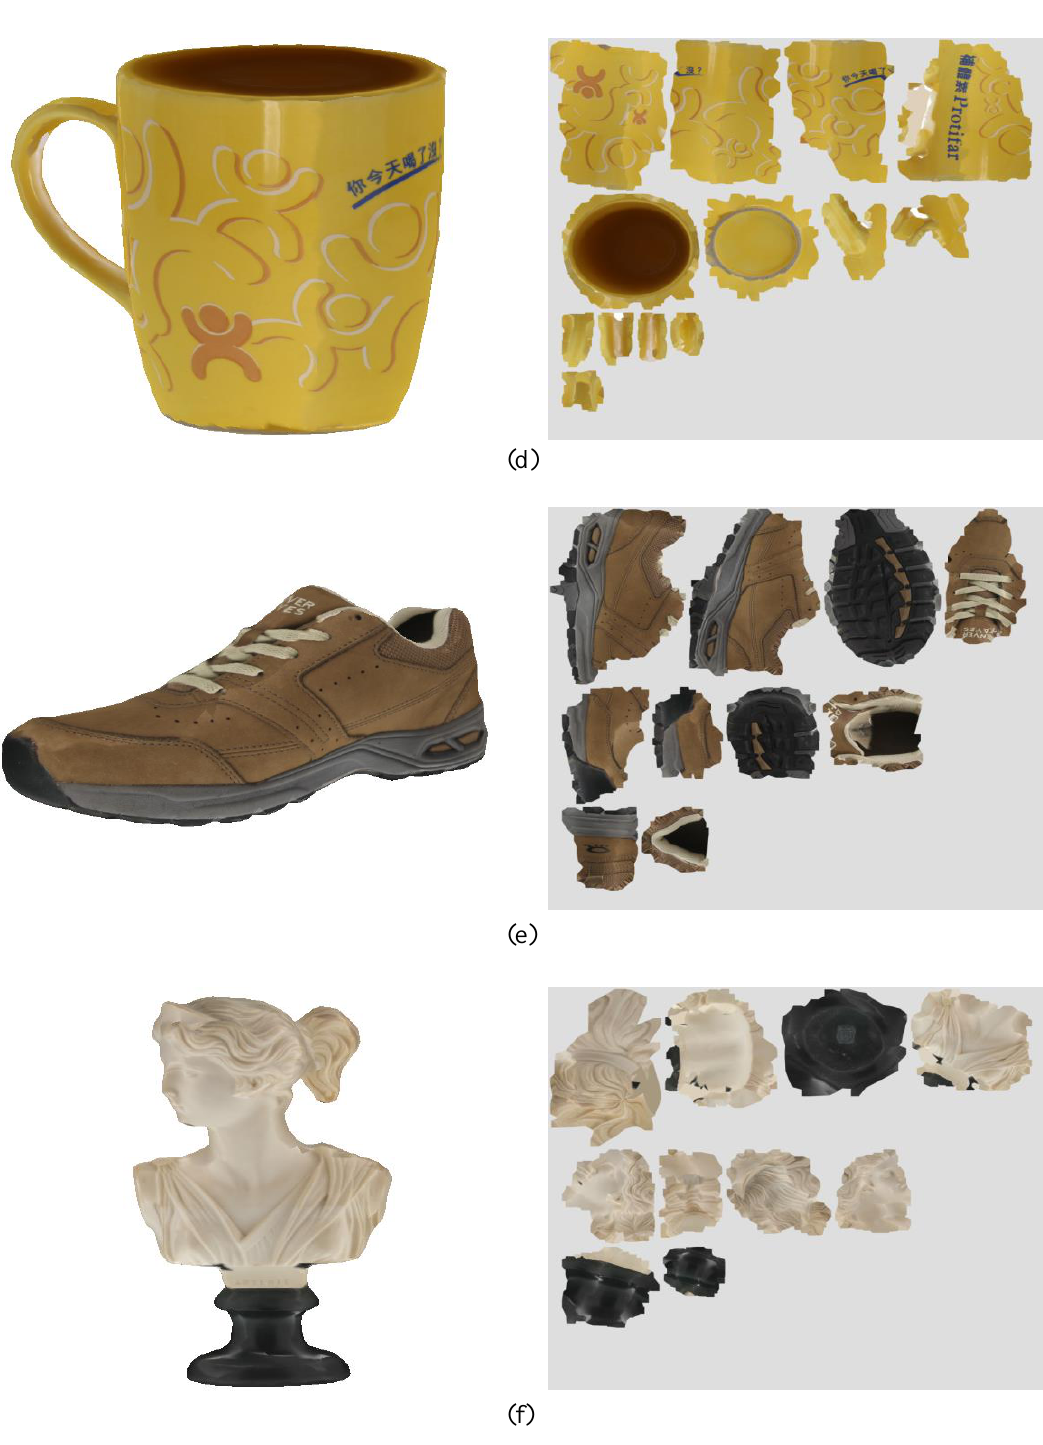
Figure 10. The results of the texture map and 3D textured model for six examples: ( a ) shoe 1, ( b ) microphone, ( c ) shoe 2, ( d ) cup, ( e ) shoe 3, and ( f ) statue.